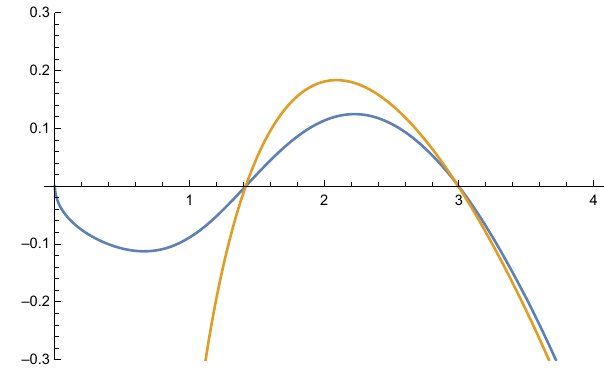
Fig. 6 The horizontal axis is r 0 ; the blue line and orange line are − g tt and g − 1 rr of the charged dilatonic blackhole for N = 2 insix dimensions at negative critical point respectively Table 3 Critical points with N = 1 in five, six and seven is the outer rr